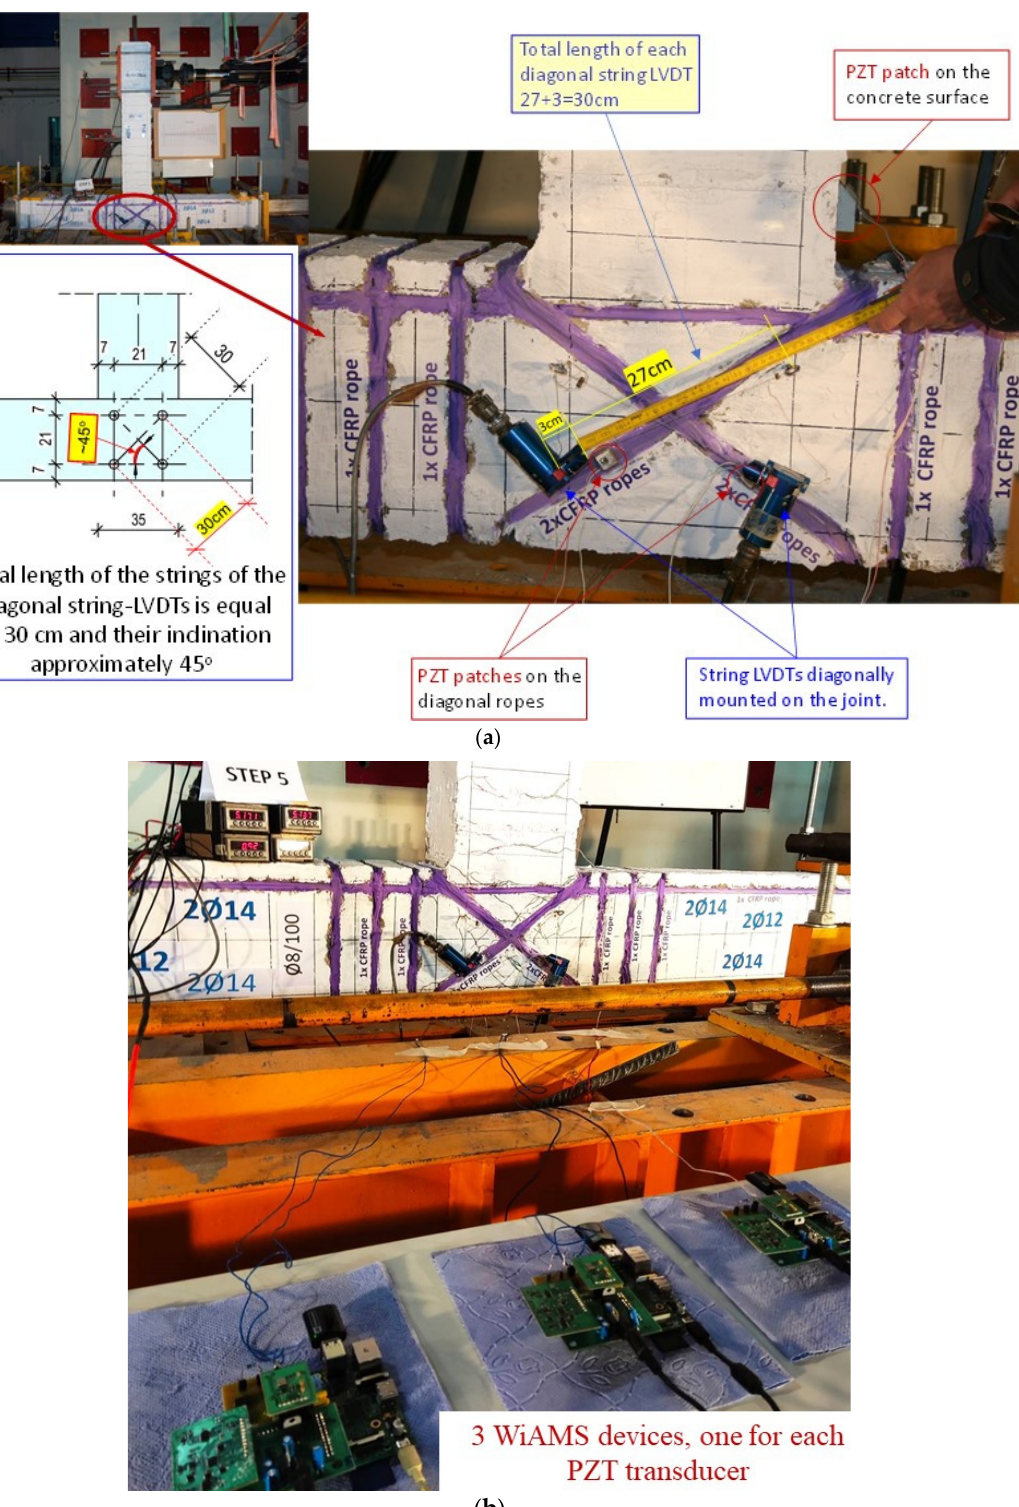
Figure 5. Measurement devices attached to specimen JC0: ( a ) Two diagonal SLVDTs and three epoxy-bonded PZT patches; ( b ) “Wireless impedance/Admittance Monitoring System (WiAMS)” devices, each one connected with two cables to the poles of each PZT patch mounted to the specimen, and detailed illustration of the small-sized SHM device.